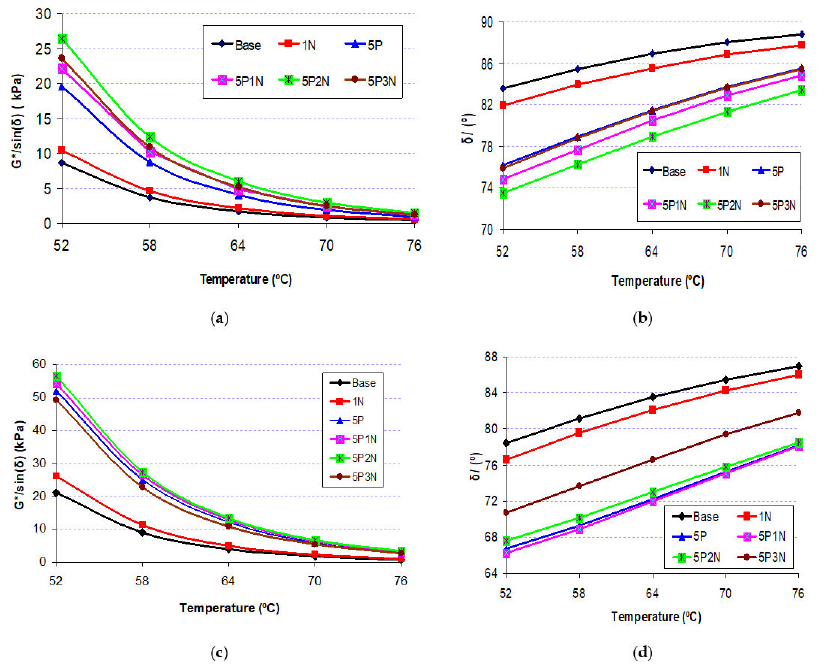
Figure 6. G*/sin( δ ) and ( δ ) of unaged and aged binder with PVC and NS contents. ( a ) Unaged; ( b ) Unaged; ( c ) RTFO-aged; ( d ) RTFO-aged.